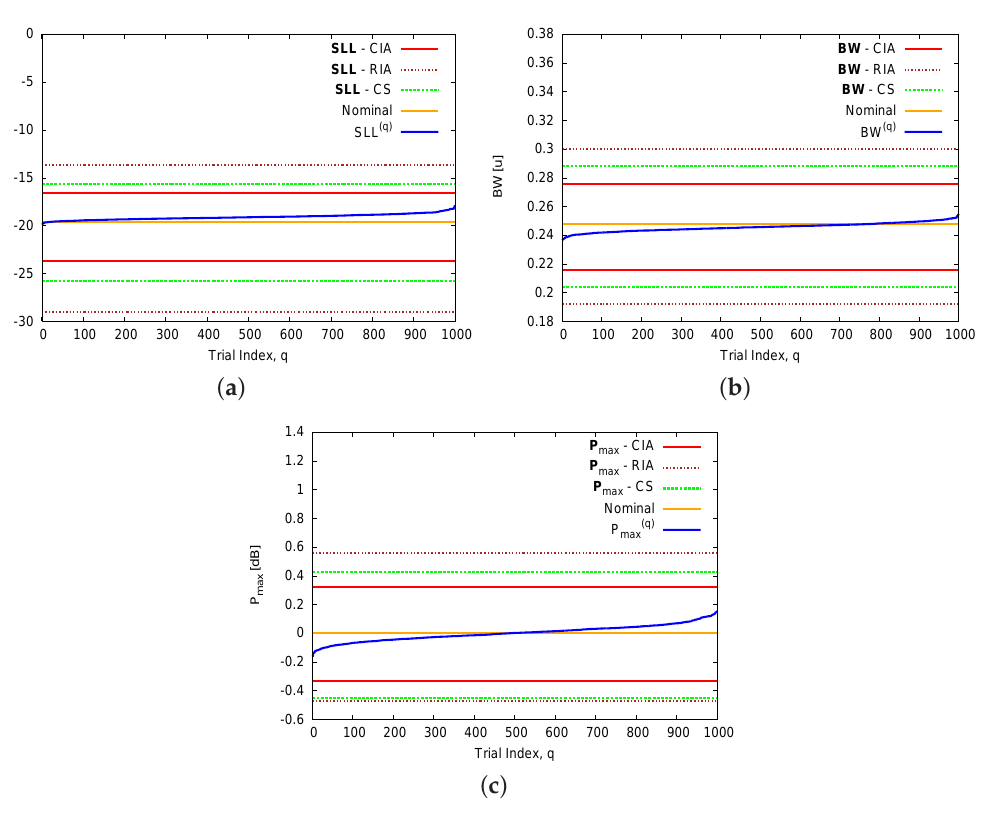
Figure 5. Calibration Error ( N = 8, d = λ ; Dolph–Chebyshev pattern: SLL ref = − 20 dB)—Nominal 2 values of the pattern indexes and bounds of the intervals ( a ) SLL ; ( b ) BW ; and ( c ) P max as computed by the CIA, the RIA , and the CS